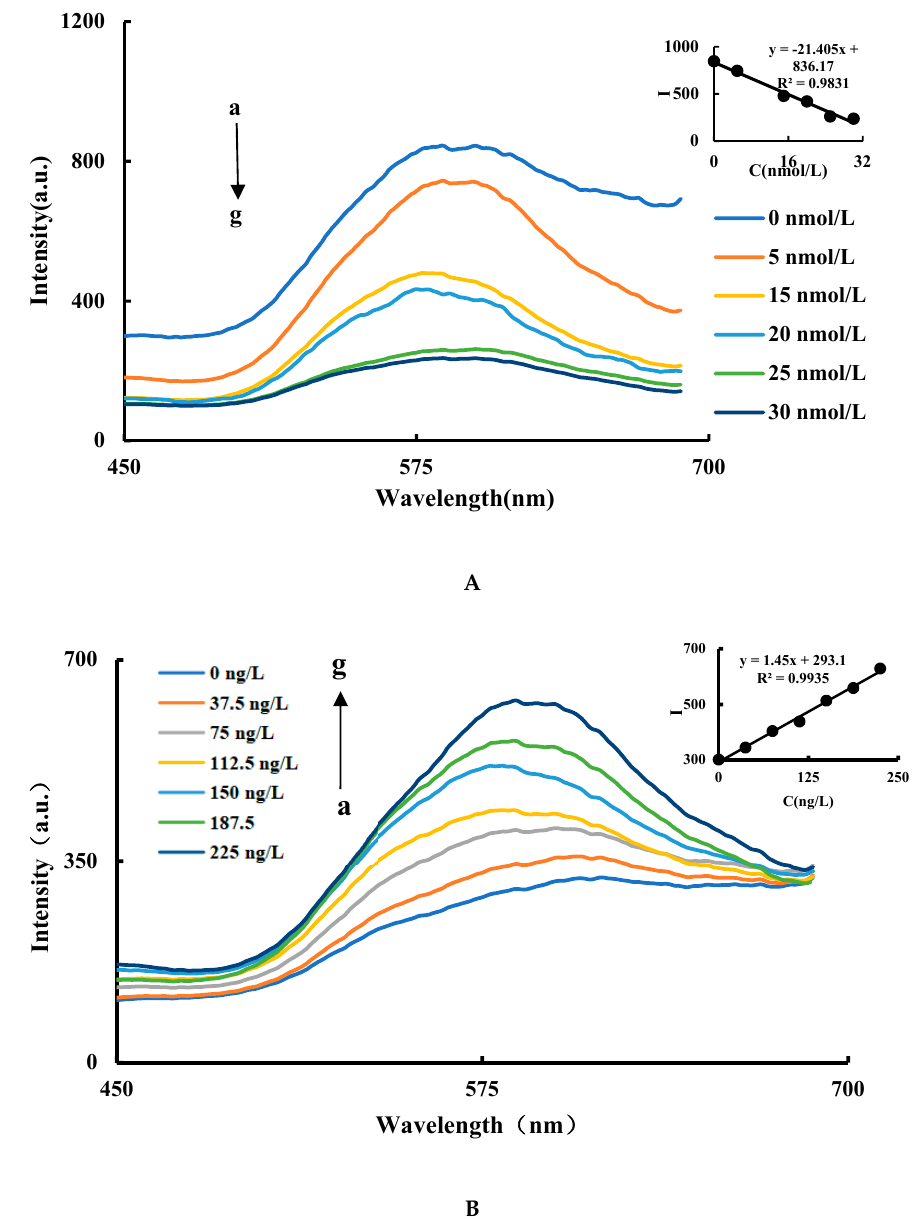
Figure 4. RRS spectra of Apt inhibition and the OTC analysis system ( A ) RRS spectra of Apt inhibition: a: 1.2 nmol/L CuNCs + 2.52 µ mol/L HAuCl4 + 1.87 mol/L ethanol + 0.65 mol/LHCl; b: a + 5 nmol/L Apt; c: a + 10 nmol/L Apt; d: a + 15 nmol/L Apt; e: a + 20 nmol/L Apt; f: a + 25 nmol/L Apt; g: a + 30 nmol/L Apt. ( B ) RRS spectra of the OTC analysis system: a: 1.2 nmol/L CuNCs + 27.5 nmol/L Apt + 2.52 μ mol/L HAuCl4 + 1.87 mol/L ethanol + 0.65 mol/L HCl; b: a + 37.5 ng/L OTC; c: a + 75 ng/L OTC; d: a + 112.5 ng/L OTC; e: a +150 ng/L OTC; f: a + 187.5 ng/L OTC; g: a + 225 ng/L OTC.